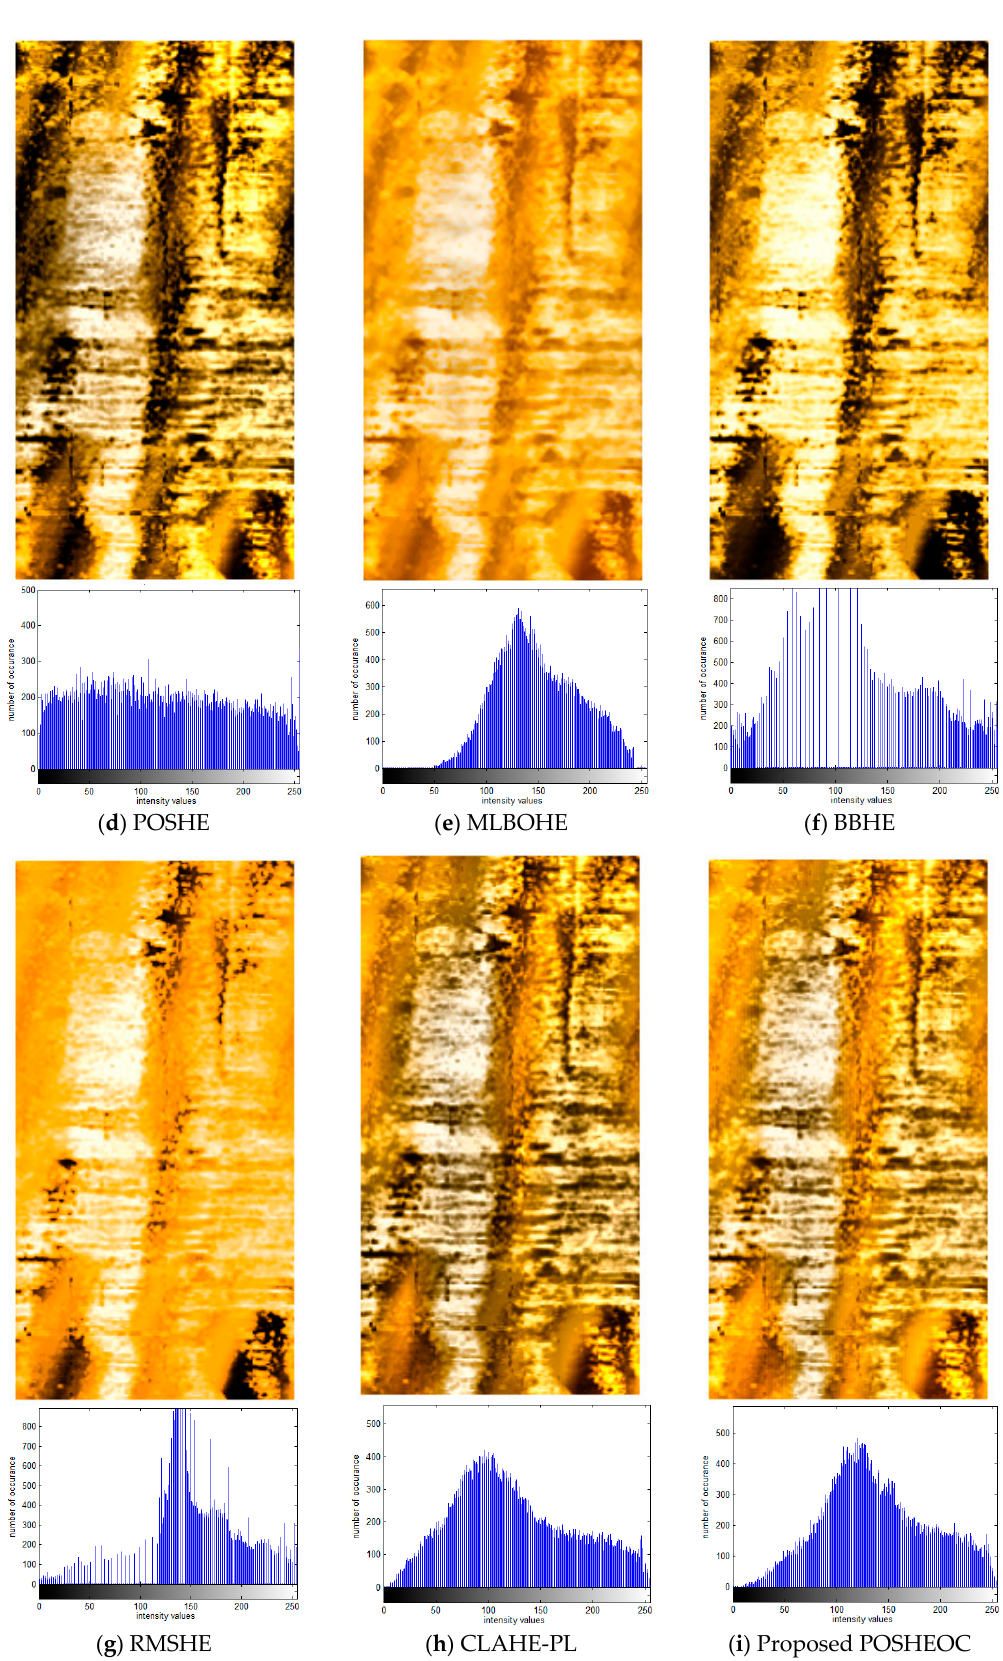
Figure 8. Comparison of enhancement results with corresponding statistical histogram using various techniques for ultrasonic logging image of Changqingyi well. ( a ) Original image; ( b ) HE; ( c ) BOHE; ( d ) POSHE; ( e ) MLBOHE; ( f ) BBHE; ( g ) RMSHE; ( h ) CLAHE-PL; ( i ) Proposed